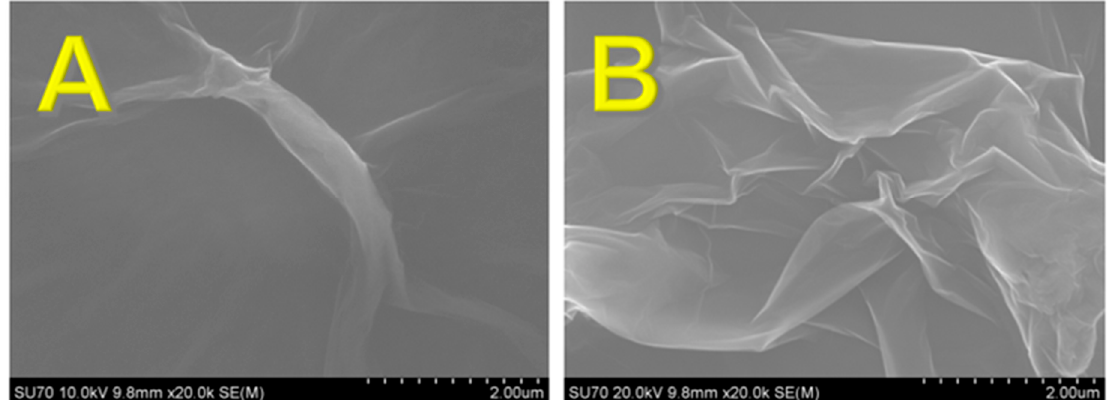
Figure 1. SEM images of the synthesized ( A ) graphene oxide (GO) and ( B ) fluorinated graphene oxide (F-GO).